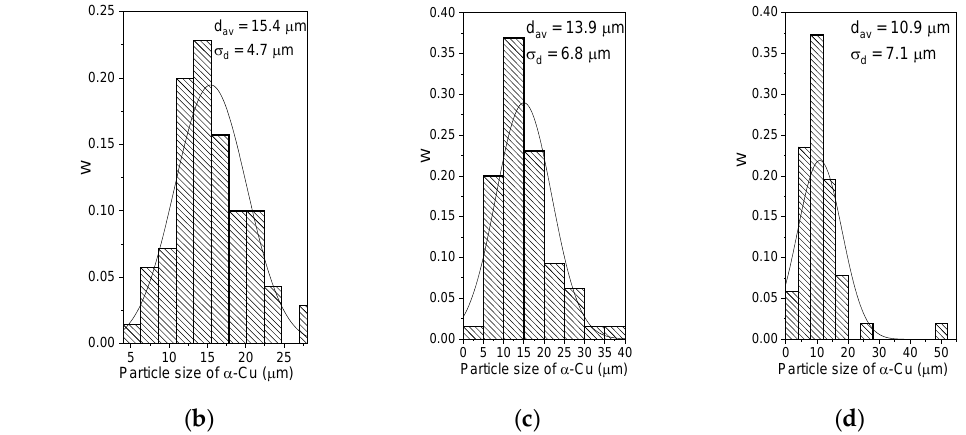
Figure 2. Microstructures of the 5% Ud ( a – c ), 10% Ud ( d – f ), 15% Ud ( g–i ) and 25% Ud ( j – l ) alloys.